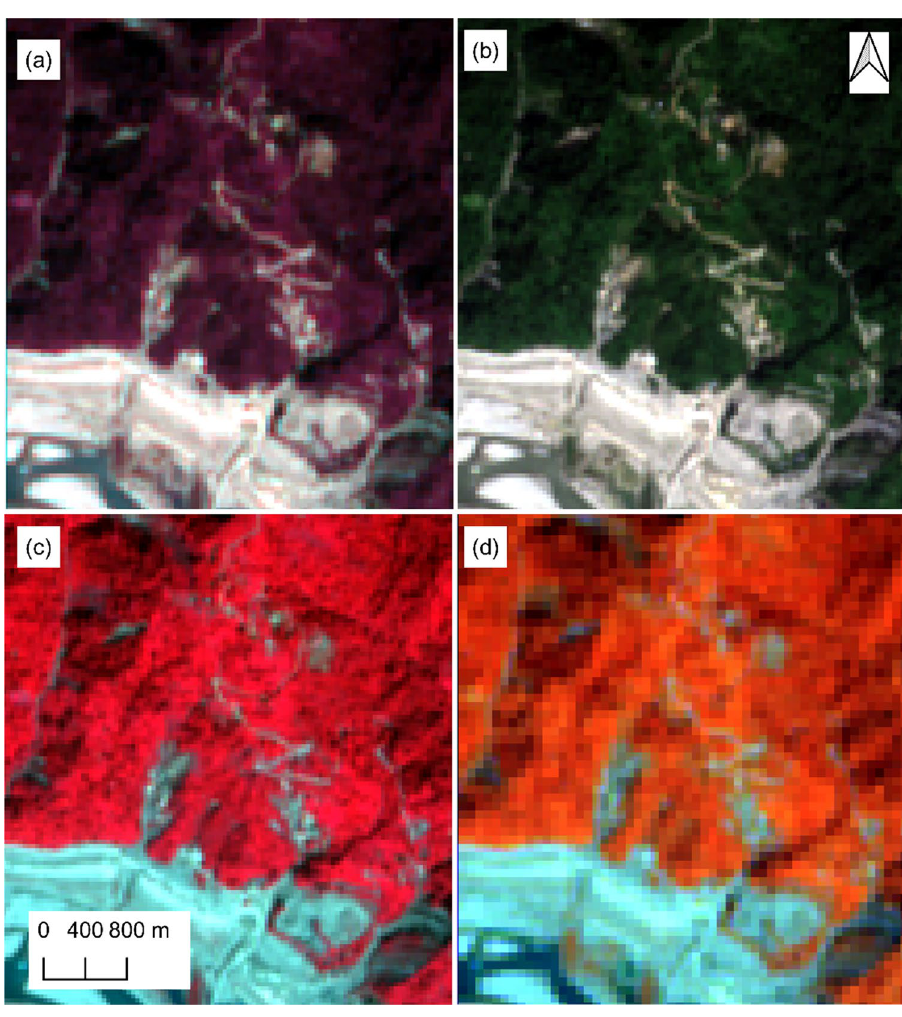
Fig. 4 Application of different colour composites of Sentinel- 2A images used to perform clustering and create a ROI of different land classes to design training samples: a RGB = 4-3-2